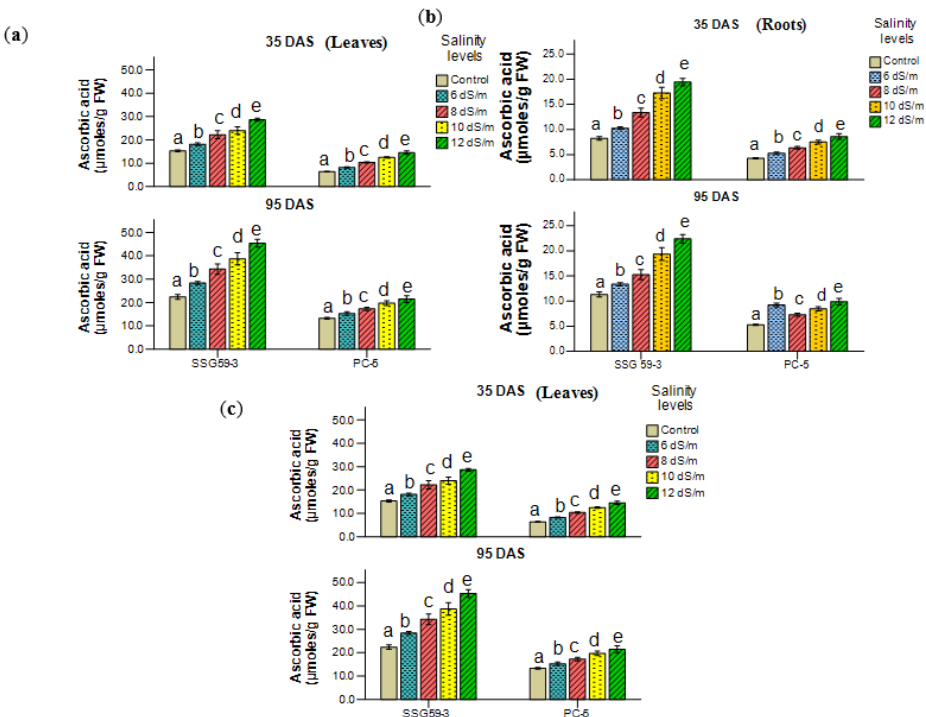
Figure 9. Effect of salt stress on ( a , b ) ascorbic acid and ( c ) carotenoids of sorghum genotypes at 35 DAS and 95 DAS. Post hoc comparisons of the means were performed using Tukey’s HSD test at p < 0.05; different letters ( a–e ) indicate significant differences among treatments within each genotype.